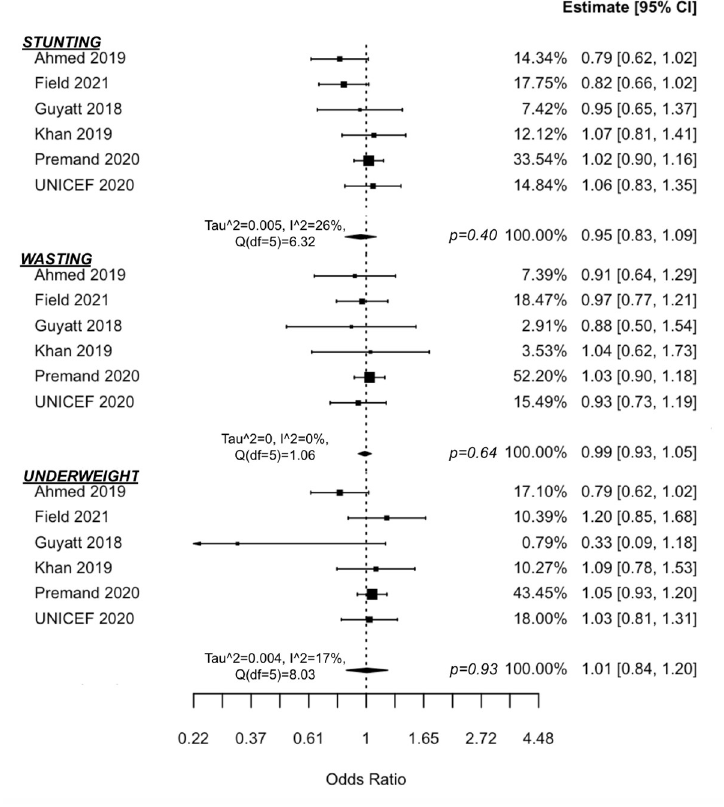
Fig 2. Forest plot of Cash + Nutrition BCC vs. cash alone on anthropometric odds ratios.